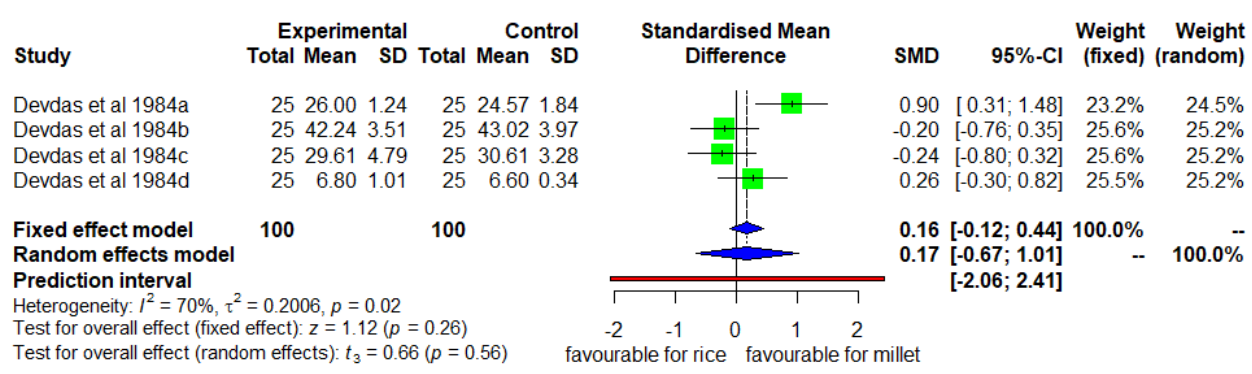
Figure 5. Effect of consuming a finger millet-based diet on mean change in chest circumference compared to a regular rice-based diet.